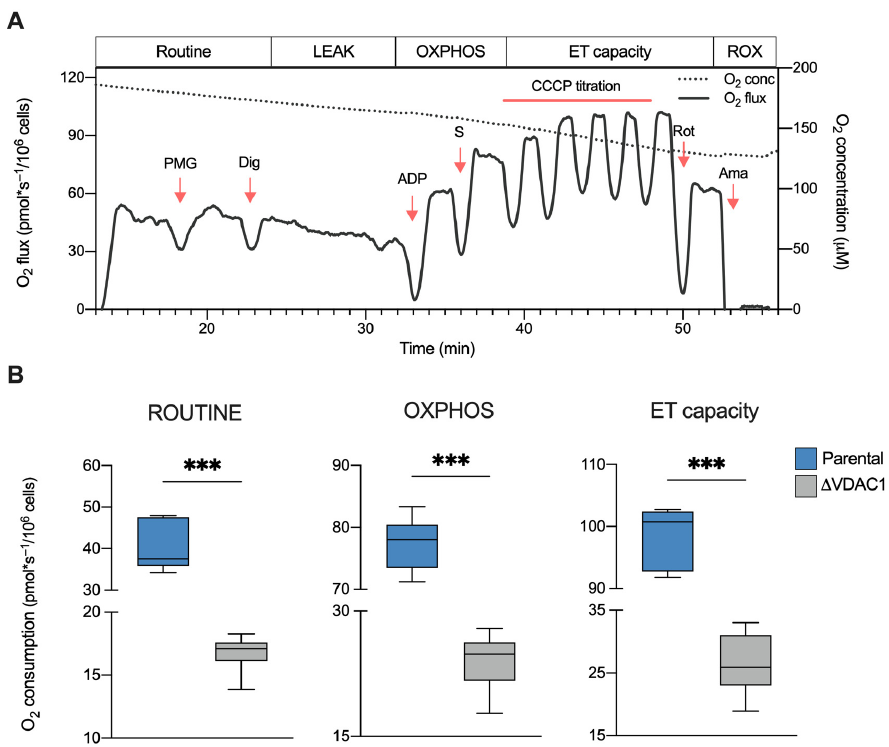
Figure 2. Oxygen consumption in HAP1 cells. ( A ) Representative curve of mitochondrial respiratory profile of parental HAP1 cells along with the SUIT protocol used for both intact and permeabilized cells. P—pyruvate; M—malate; G—glutamate; Dig—digitonin; S—succinate; Rot—rotenone; Ama—antimycin. ( B ) Quantitative analysis of the oxygen consumption rate of ROUTINE, OXPHOS, and maximal ET capacity in HAP1 cells, expressed as pmol/second per million cells. A significant reduction of oxygen consumption was observed in each state for Δ VDAC1 cells in comparison to parental. Data are shown as median ± SEM of n = 6 independent experiments and statistically analyzed by unpaired t -test, with *** p < 0.001.